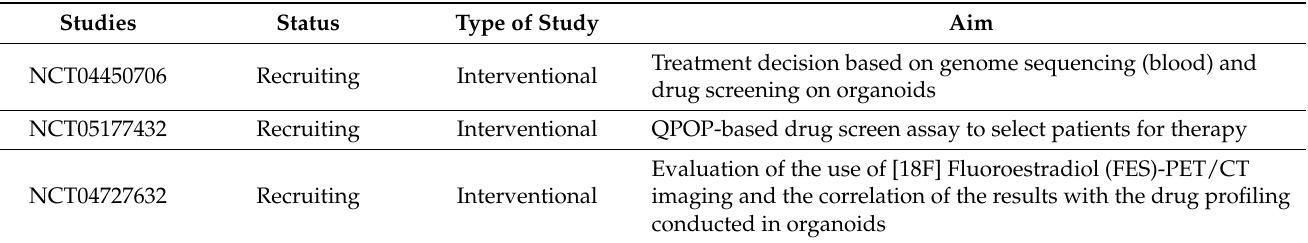
Table 6. Clinical trials investigating PDTO models in breast